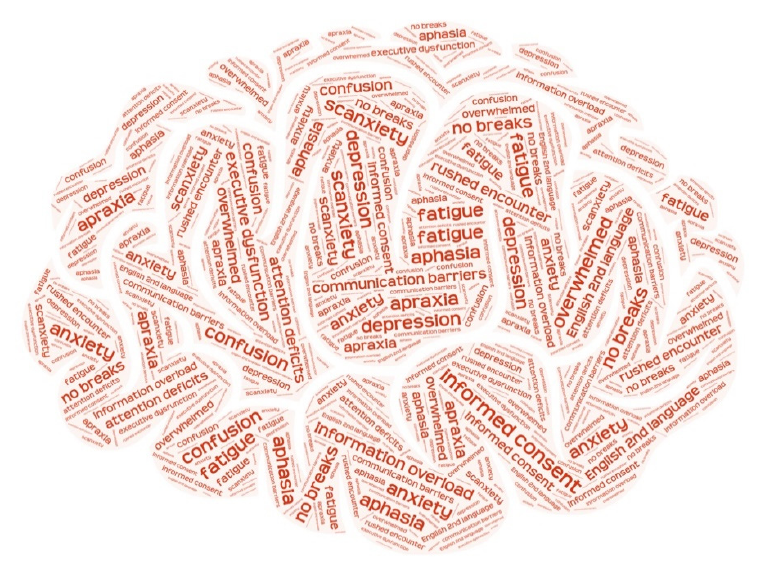
Figure 1. Word cloud of competing factors for neuro-oncology patients participating in cognition research.